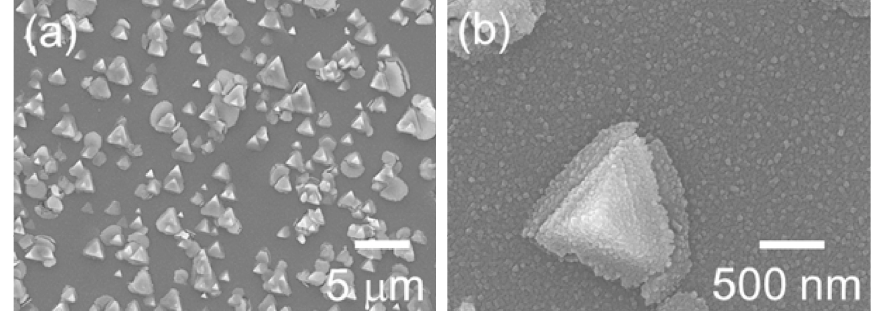
Figure 1: FE-SEM micrographs of Cu